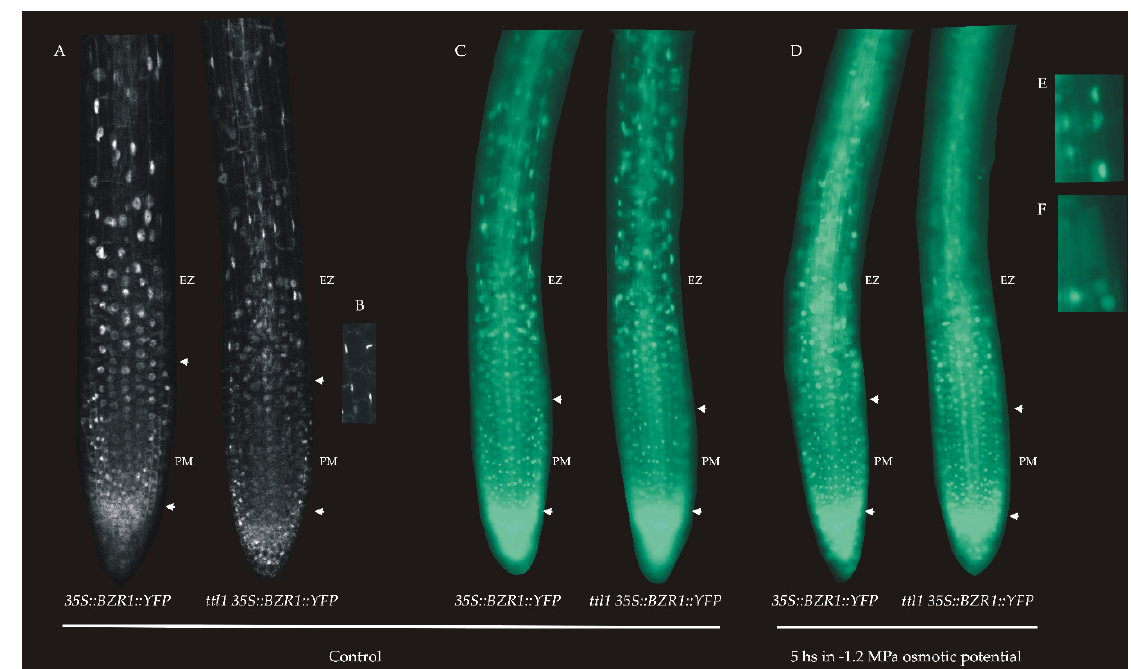
Figure 8. ( A ) Expression pattern of BZR1 in roots of Col-0 and ttl1 mutant grown during 7 days in control conditions. ( B ) Zoomed in view of TZ showing the nuclear expression pattern in ttl1. This pattern suggests that cellular expansion begins earlier than in Col-0. Images were taken with Confocal Microscopy Zeiss LSM800—AiryScan n = 10. ( C – F ). Expression pattern of brassinosteroids (BR) in response to 5 h of severe osmotic stress. ( C ) 35S::BZR1::YFP in Col-0 and ttl1 mutant plants grown in control medium showing the YFP signal in the nuclei of EZ epidermal cells. ( D ) 35S::BZR1::YFP in Col-0 and ttl1 mutant plants grown during 5 h of severe osmotic stress showing YFP signal localized in the cytoplasm of epidermal EZ cells. ( E ) Zoomed in view of signal in epidermal EZ cells of ttl1 mutant grown in control condition showing the nuclei localization of YFP signal. ( F ) Zoomed in view of signal in epidermal EZ cells of ttl1 mutant grown in hyperosmotic condition showing the cytoplasmic localization of YFP signal. Images were taken with Epifluorescence microscope ZEIZZ—AXIO Imager. M2.